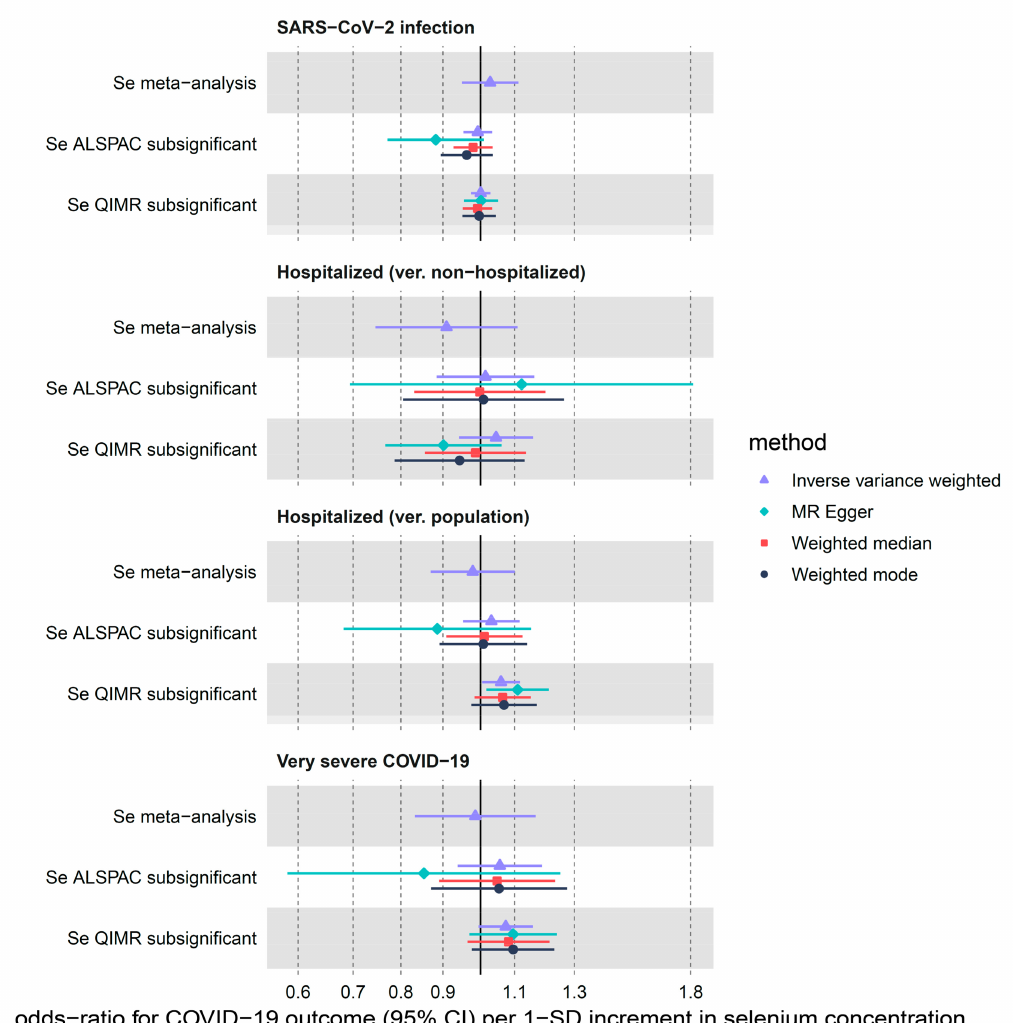
Figure 2. MR estimates for the effect of circulating selenium (Se) on three COVID-19 outcomes obtained using 4 different statistical methods. We used three sets of selenium instruments: Se refers to instruments with p -values < 5 × 10 − 8 and sub-significant Se refers to instruments with p -values < 5 × 10 − 5 in the ALSPAC and QIMR